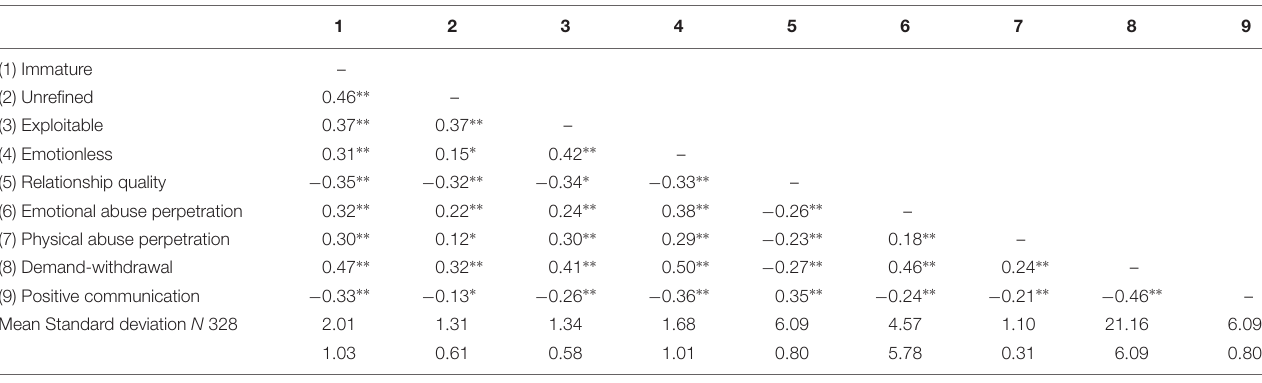
TABLE 5 | Study 3 descriptive statistics and zero-order correlations between the perpetration version of the DIRRS and other study variables.